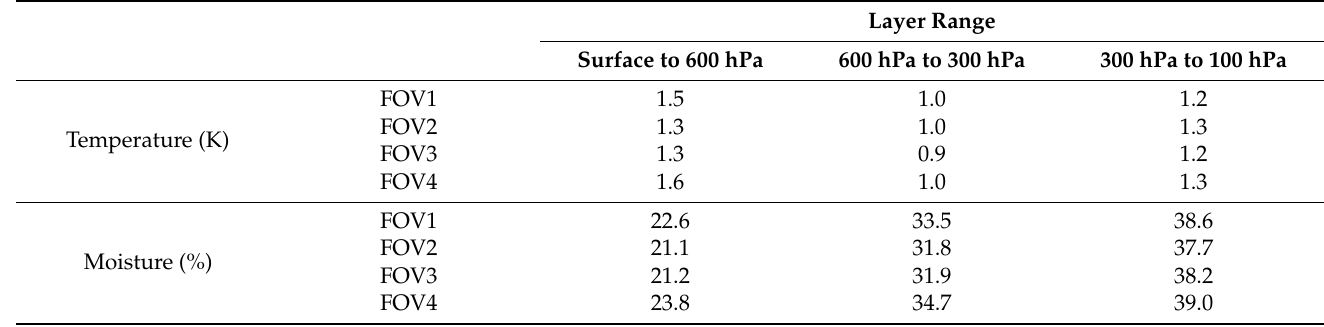
Table 3. The mean RMSE of the temperature and relative humidity between the retrieval results and the ERA5 data for different FOVs in three broad